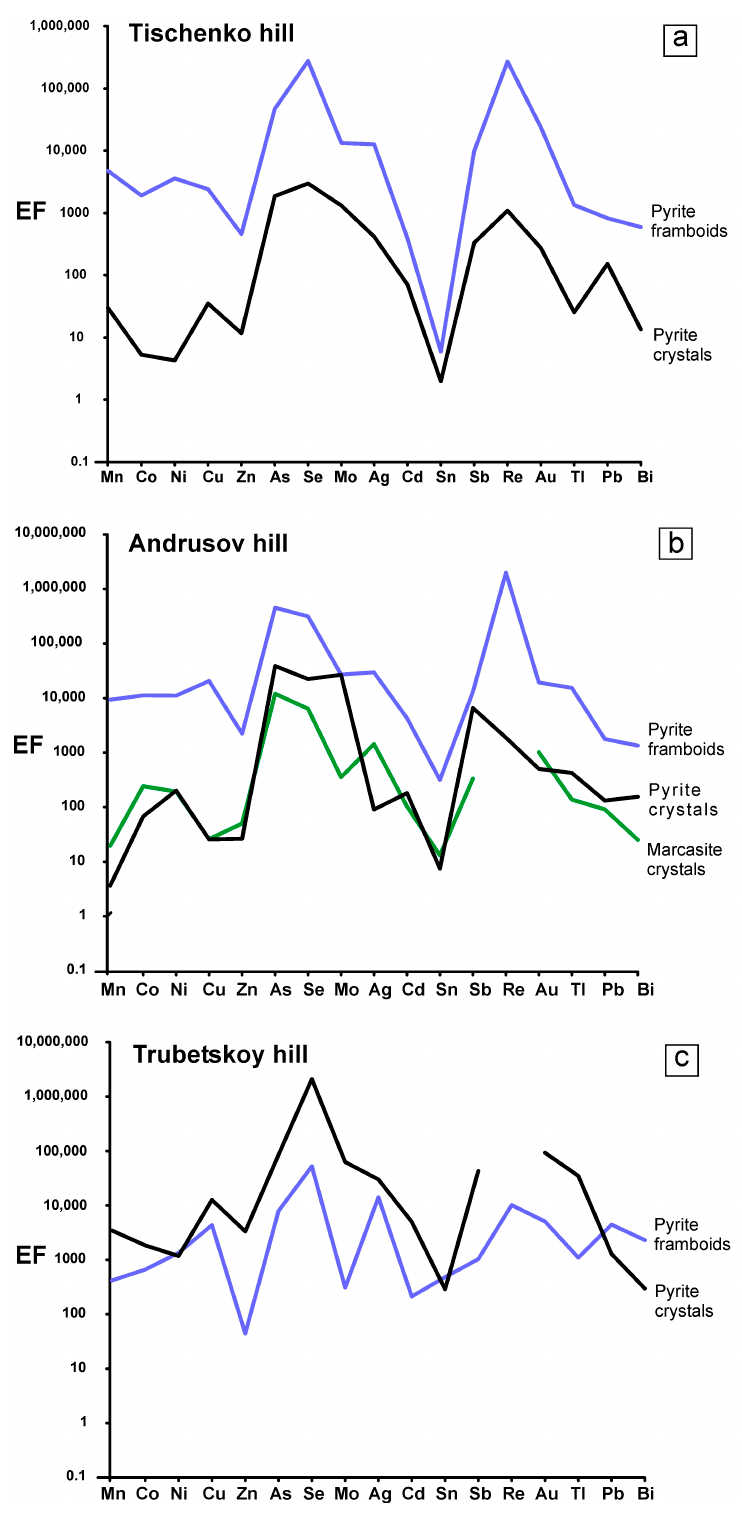
Figure 14. Incorporation of trace elements in different textural forms and polymorphic modifications of FeS 2 . LA-ICPMS analyses of pyrite and marcasite (Tables 7 and 8). Relative enrichment factor: EF element = ([C] element /[C] Al ) sample /([C] element /[C] Al ) PAAS [45]. PAAS after [75]. ( a ) Tischenko hill, ( b ) Andrusov hill, ( c ) Trubetskoy hill.